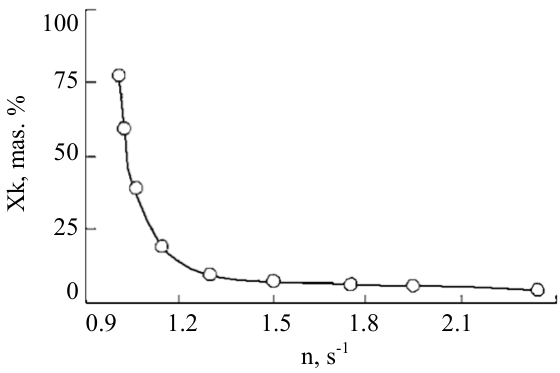
Fig. 5 shows a change in the